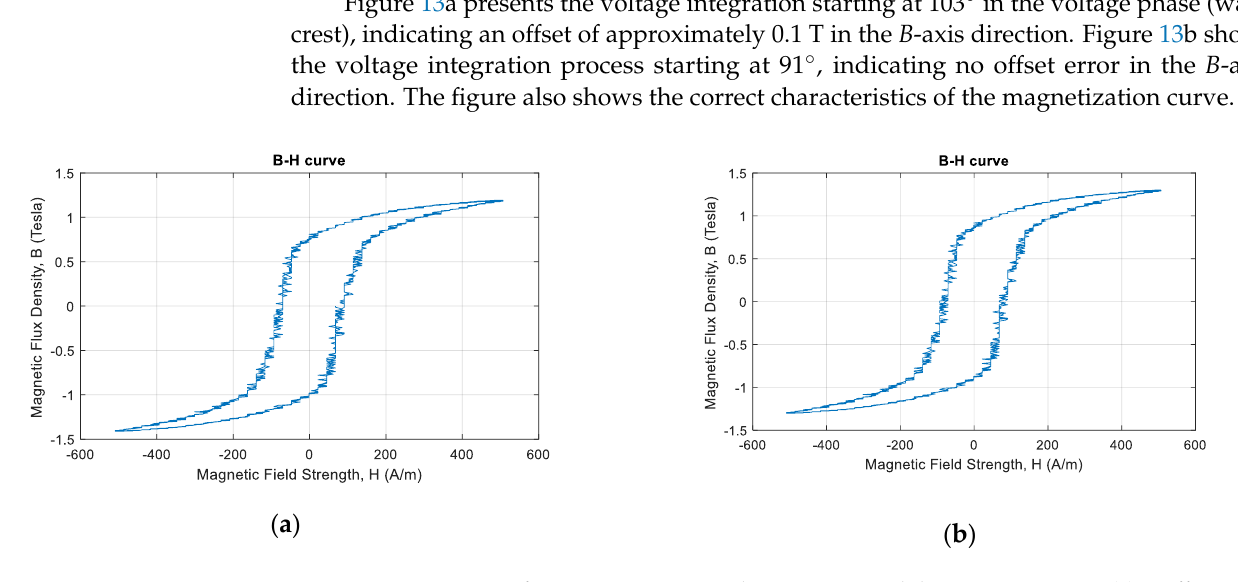
Figure 13. B – H curves from a test using a voltage source with harmonic content. ( a ) B offset error ( b ) After correction of initial integration position and removal of the DC components